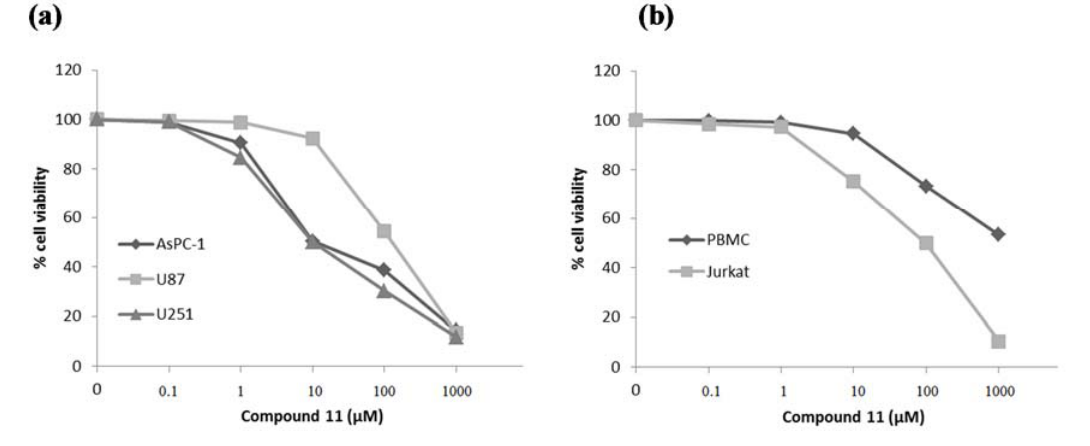
Figure 3. Effects of compound 11 on cell viability of AsPC-1, U87, U251 cell lines ( a ) and PBMC, Jurkat cell lines ( b